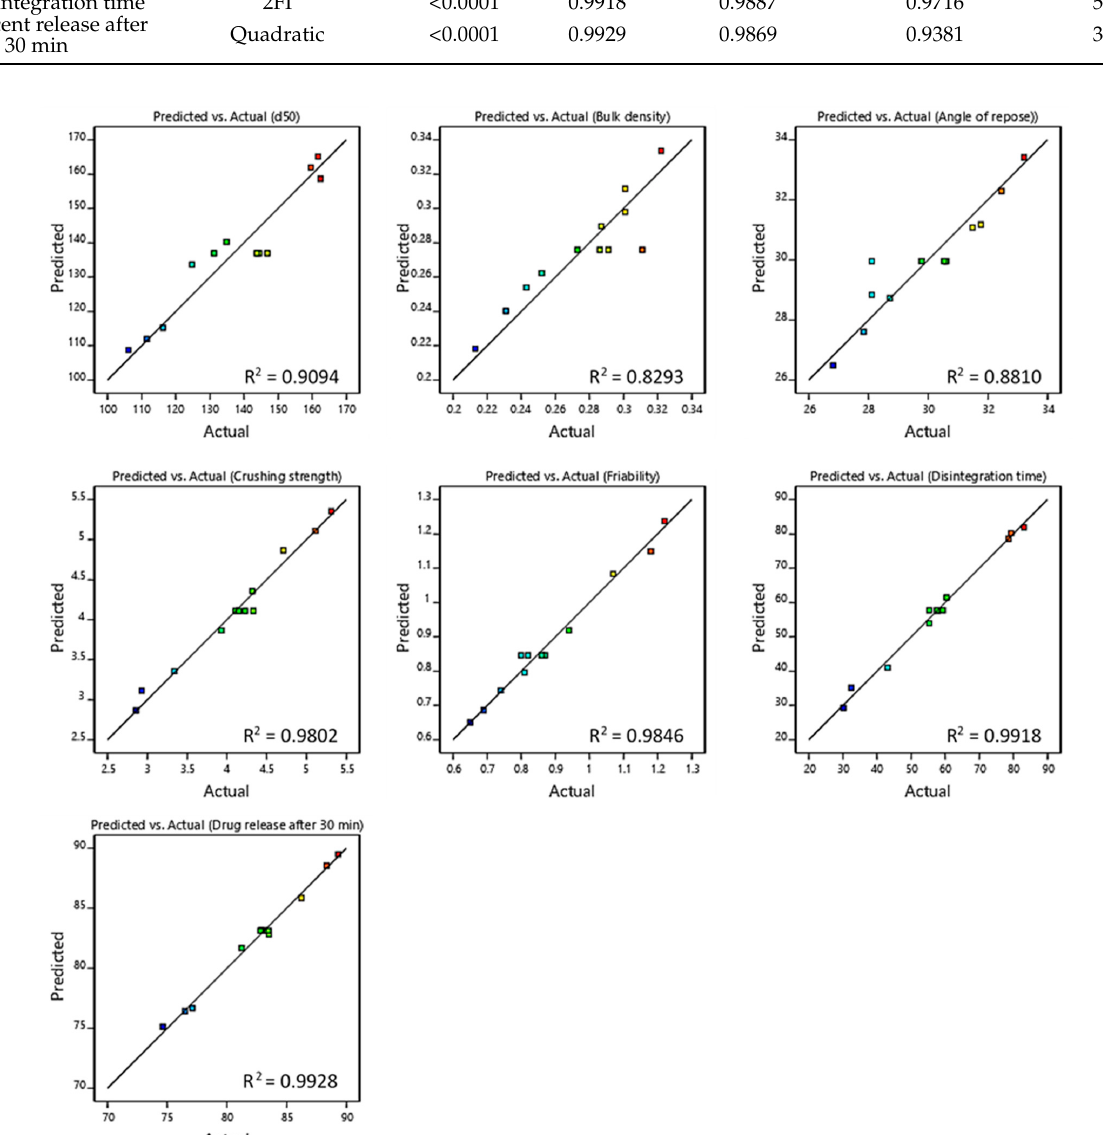
Figure 1. Linear correlation plot relating mean granule size, bulk density, angle of repose, crushing strength, friability, disintegration time, and drug release after 30 min between the predicted and the actual values.